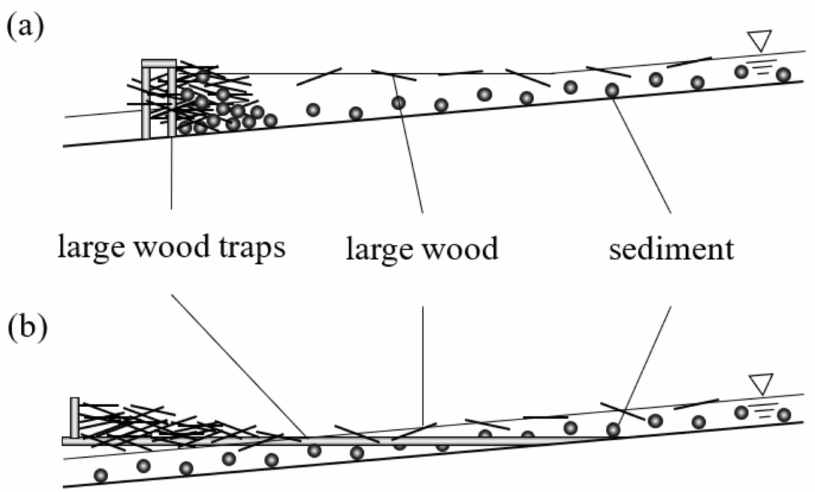
Figure 3. Side views of traps capturing LW: ( a ) Typical LW trap featuring vertical columns; ( b ) New LW trap with horizontal rods proposed in the present